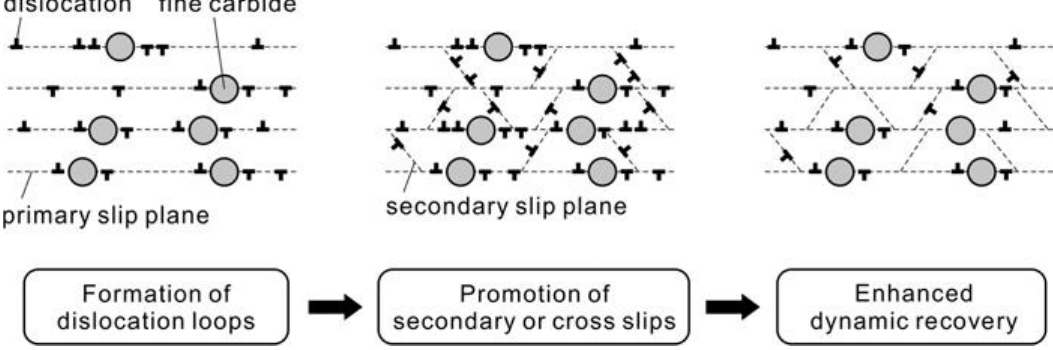
Figure 6. The dislocation-TiC carbide interactions during deformation. The interactions between dislocations and back stresses generated from the Orowan looping mechanism activate the secondary slip systems, leading to improved strength without sacrificing ductility in TiC carbide strengthened steels [29].